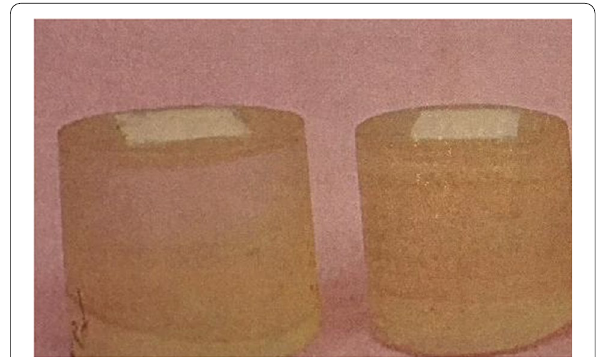
Fig. 1 Slices embedded in the acrylic blocks